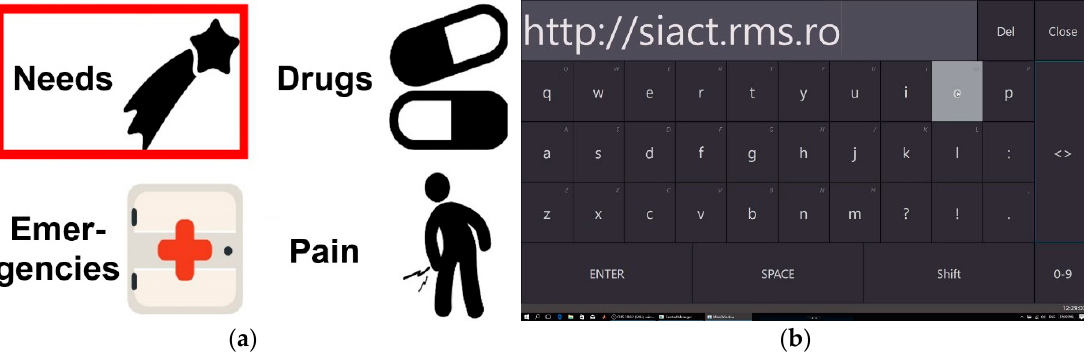
Figure 4. Two-way communication function of the proposed assistive system: ( a ) ideograms / keywords displayed on the patient display; ( b ) virtual keyboard used to build sentences.